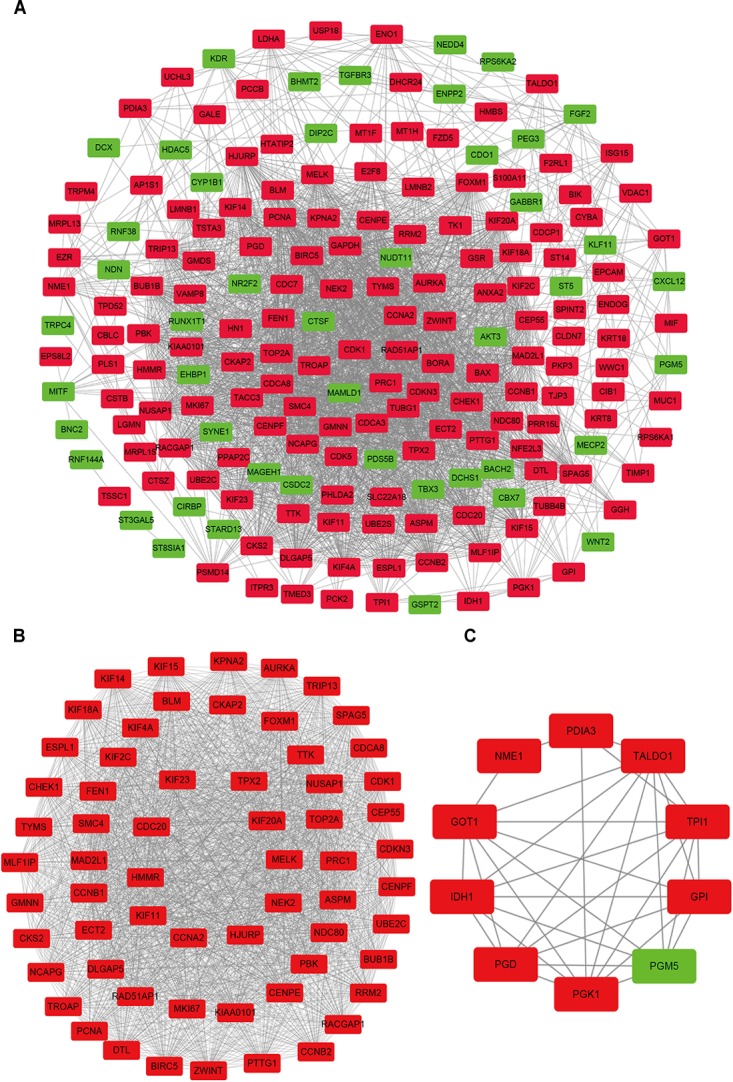
Protein–protein interaction network of common DEGs and module analysis. (A) PPI network of proteins encoded by the DEGs, including 194 nodes and 2,581 edges. The yellow circle represents module 2 and the purple circle represents module 1. (B) Module 1 consisted of 62 nodes and 1,810 edges. (C) Module 2 consisted of 10 nodes and 33 edges. Red nodes and green nodes represent upregulated and downregulated DEGs, respectively. PPI, protein–protein interaction; DEGs, differentially expressed genes.